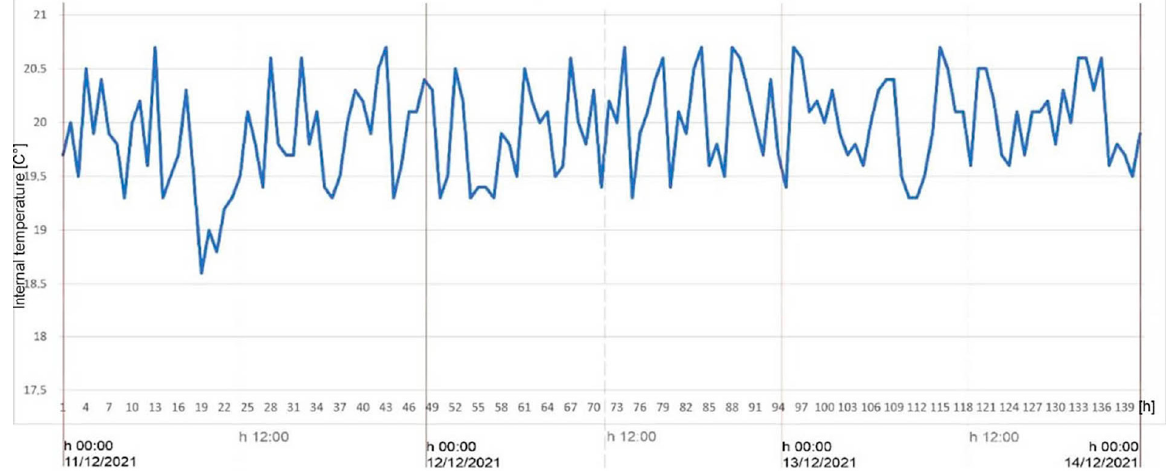
Figure 16. Internal temperature diagram as a function of time: post operam.